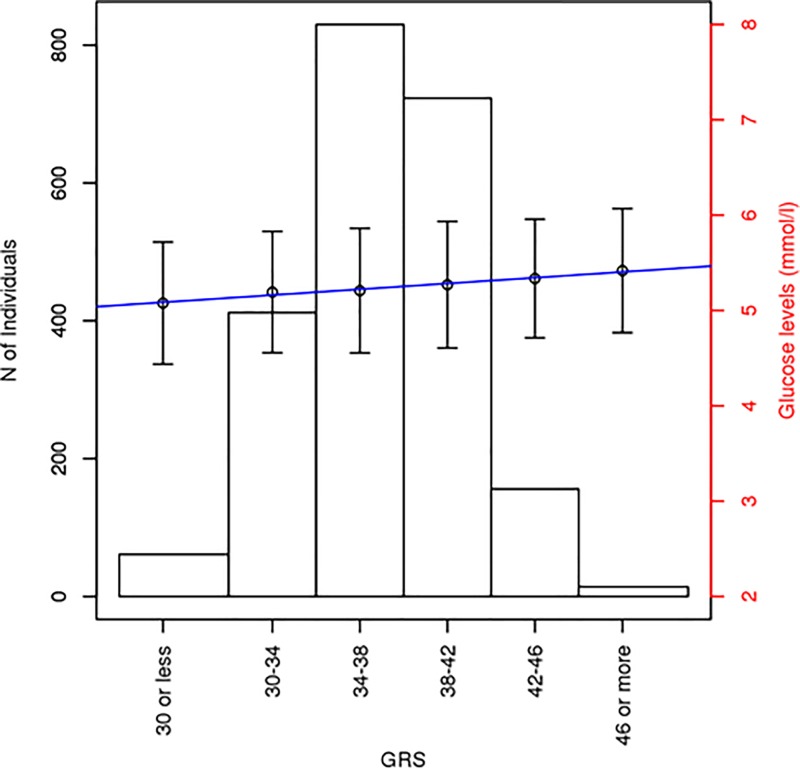
Distribution of individuals in every genotype score group and cumulative effects of the risk alleles from the 36 SNPs for glucose levels.The bar plots show the average and standard error of glucose in mmol/L for each genotype score group distribution of the genetic risk score.